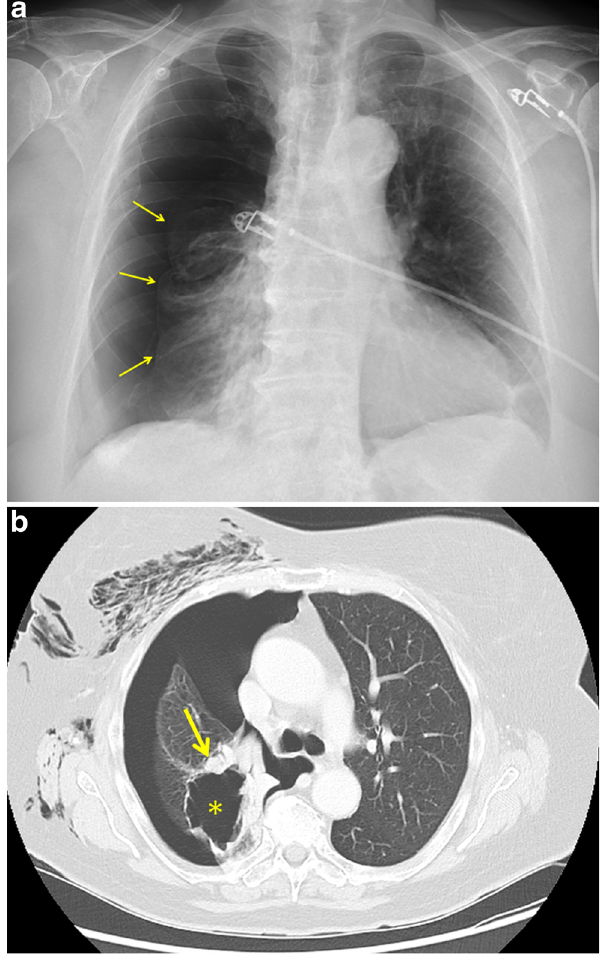
Fig. 3 Spontaneous pneumothorax as the first sign of a primary lung carcinoma in an 87-year-old woman who presented at the emergency department with thoracic pain and severe respiratory distress. a Supine anteroposterior chest radiograph clearly depicts a right-sided pneumothorax with complete collapse of the right lung. The visceral pleural edge is observed clearly as a very thin, sharp line ( yellow arrows ) with the absence of vascular marking beyond the pleural line. b Axial contrast-enhanced chest CT in lung window setting shows a large thin-walled cystic lesion ( asterisk ) with peripheral solid nodular component ( yellow arrow ) in the right upper lobe as the underlying cause of the pneumothorax. Also, note the extensive subcutaneous emphysema in the right chest wall. Histopathological diagnosis of adenocarcinoma (type B lung cancer associated with cystic airspaces ^ ) was made after lobectomy